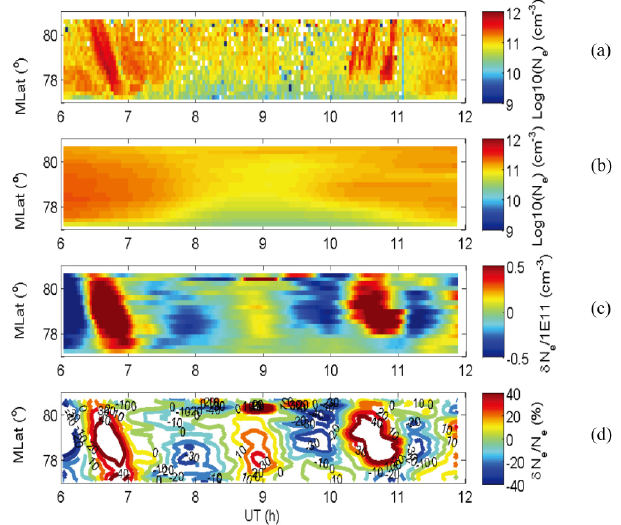
Fig. 6. The same as Fig. 2 but for the ESR 32m dish, which